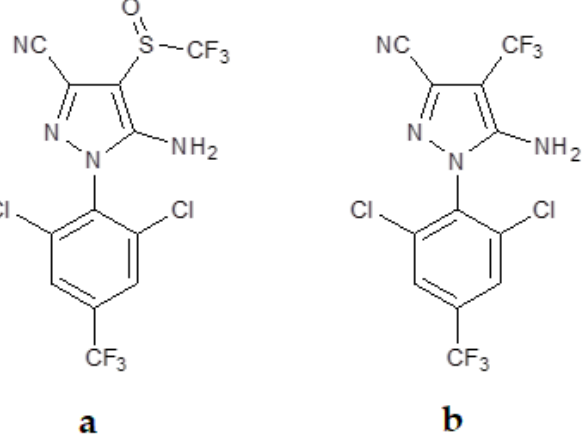
Figure 1. Chemical structure of dipronil ( a ) and its desulfurated derivative desthiofipronil ( b ).